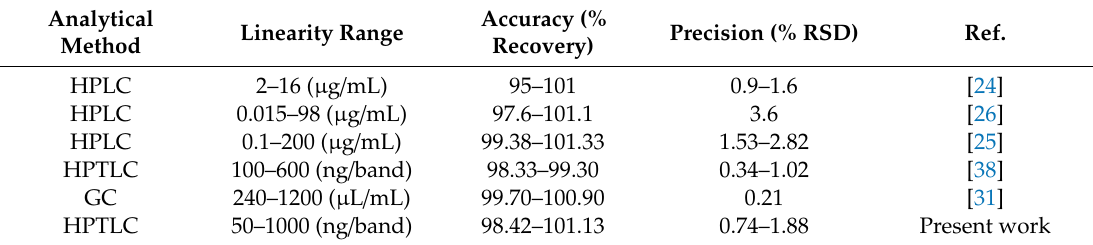
Table 6. Comparison of the present green RP-HPTLC method with the previous literature’s methods for the quantitative analysis of